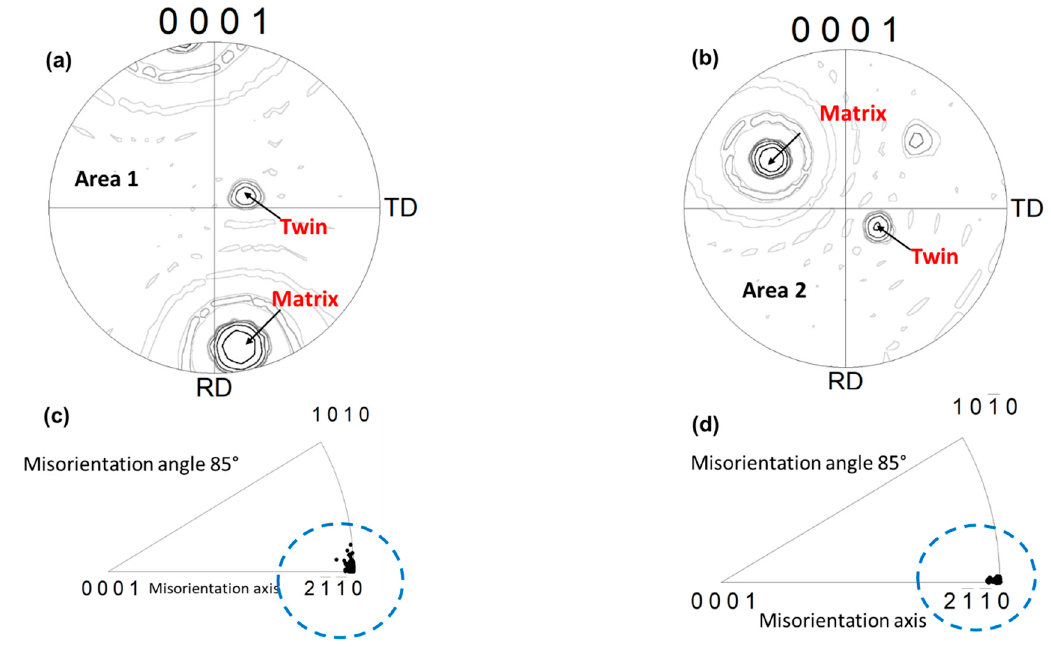
Figure 11. The misorientation between the deformation twins and the surrounding matrix (shown in Figure 10): ( a , b ) {0001} pole figures and ( c , d ) inverse pole figures illustrating the misorientation angle and axis pair for area 1 and area 2.